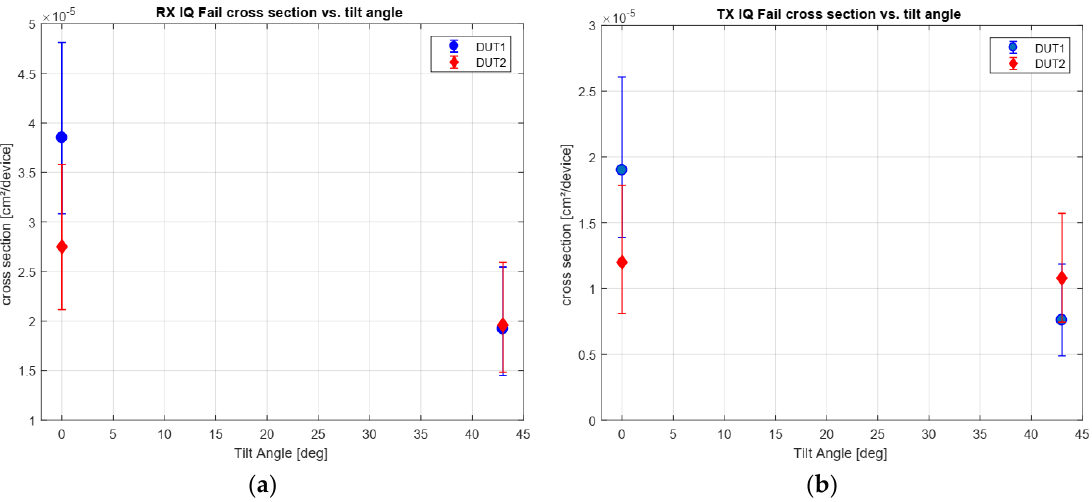
Figure 21. Tilt angle dependency for ( a ) TX and ( b ) RX IQ SEFIs (Hard and Soft in total) at a LET of 62.5 MeV.cm²/mg with Xe 0° tilt angle and Rh on 43° tilt angle.